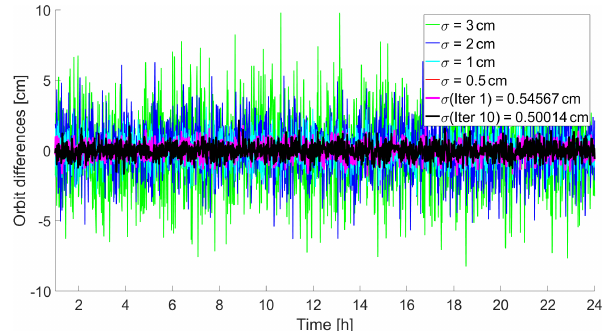
Figure 7. Resulting amplitude of error of combined solution with different phase shifts when using three individual solutions for the